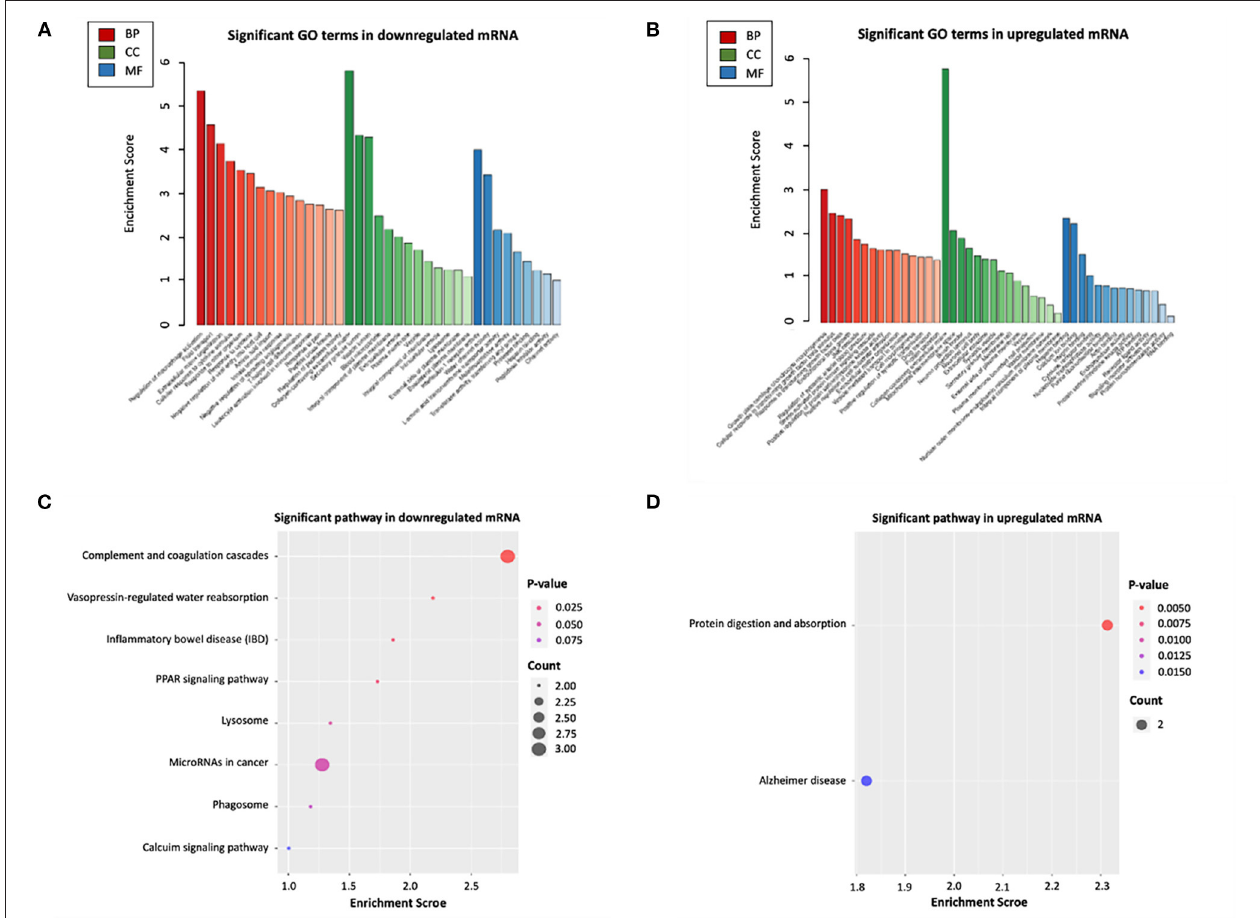
FIGURE 4 | Functional enrichment analysis of differentially expressed mRNAs in ceRNA networks. (A) GO biological functional analyses of downregulated mRNA; (B) GO biological function analyses of upregulated mRNA; (C) KEGG pathway analyses of downregulated mRNA; (D) KEGG pathway analyses of upregulated mRNA. BP, biological process; CC, cellular component; MF, molecular function; GO, Gene